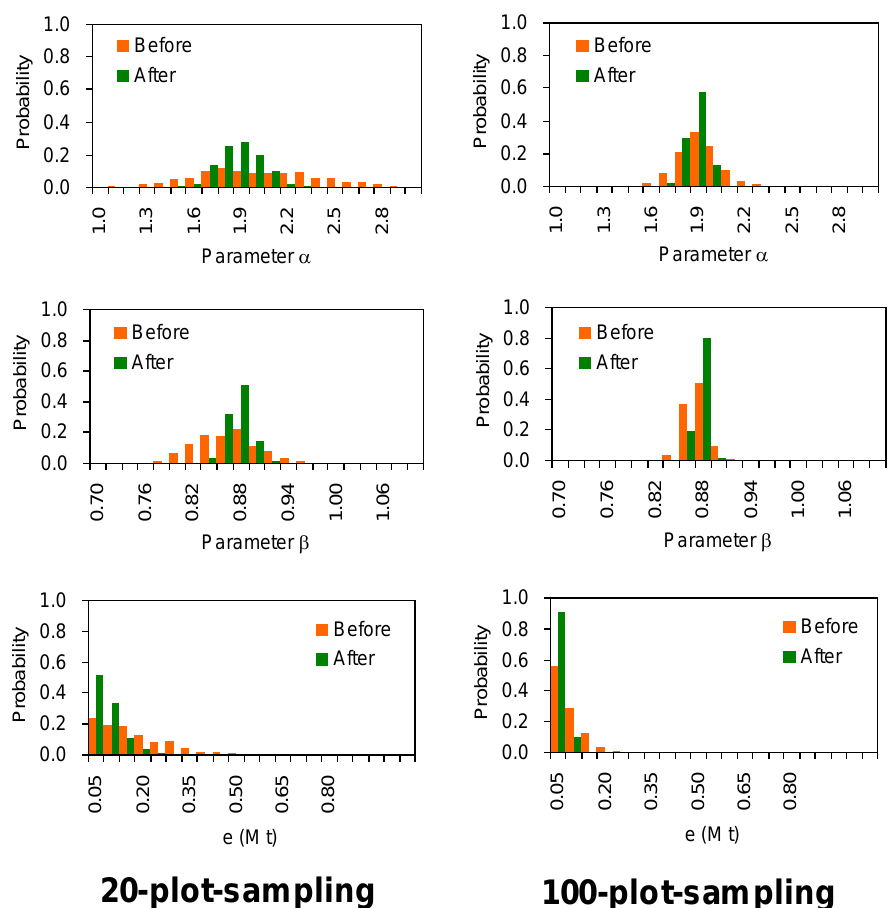
Figure 5. Comparison between two estimations before and after improving the parameters based simulated pseudo data. Averaged parameters ( α and β ) and residual (e) distributions resulted from 500 simulations of setting field plot. The model estimates are calculated using Equation (3) with parameters before and after improvement. For the data details refer to the footnotes of Table 2.